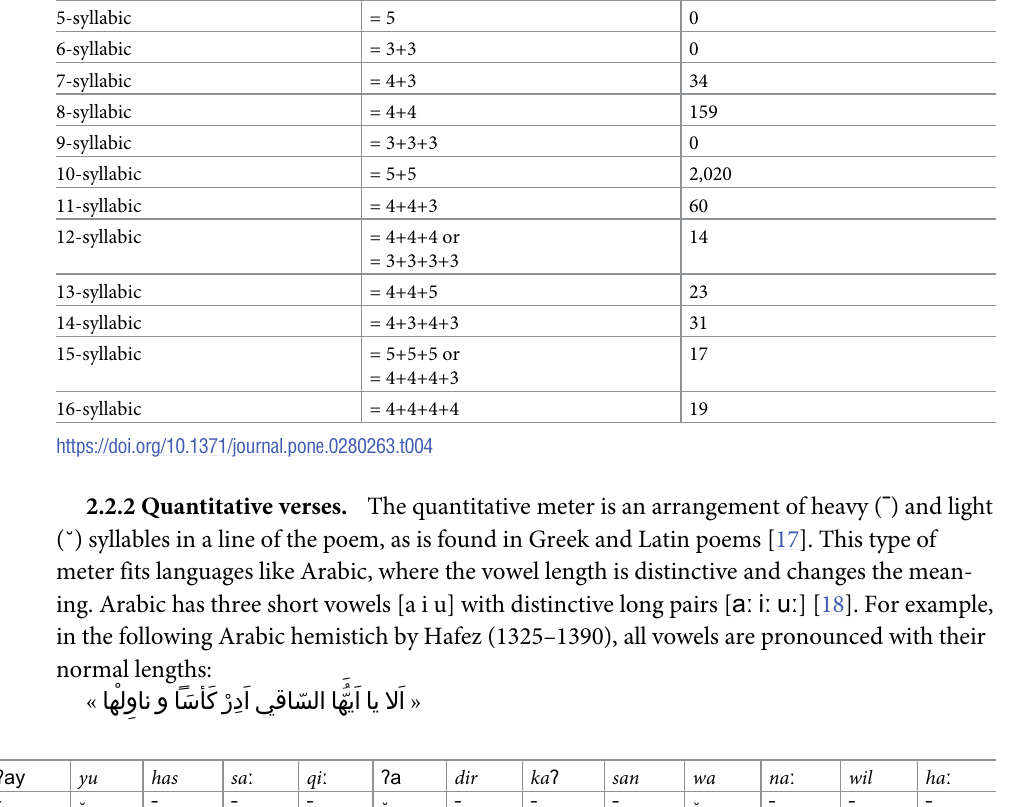
Table 4. Types of syllabic verses in Kurdish poetry (Frequencies from VejinBooks corpus, up to 2019/12/1). Type Feet